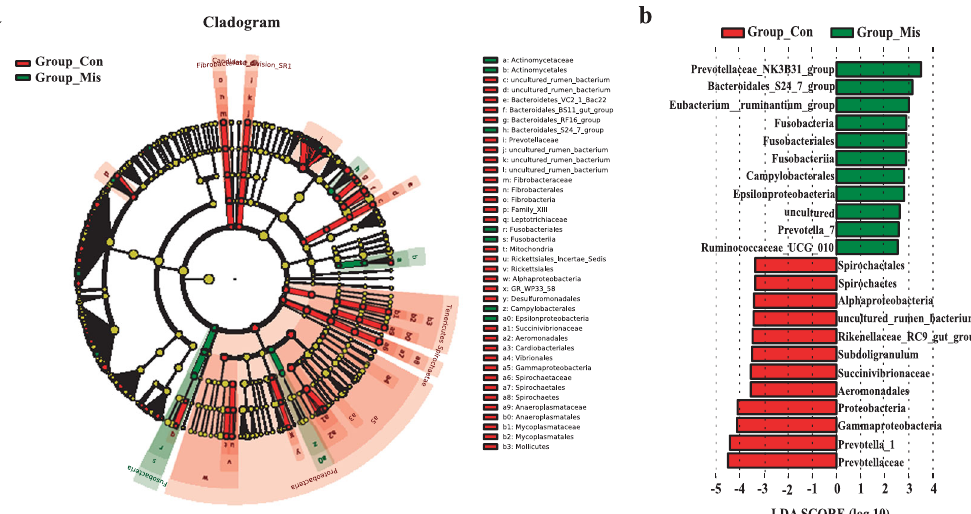
Fig. 3 Compositions of different species in the control and miscarriage groups by LEfSe analyses. a Taxonomic representation of statistically and biologically consistent differences between the control and miscarriage groups. Signi fi cant differences are represented with different colors (red and green represent core microbes in the control (Con) and miscarriage (Mis) groups, respectively; yellow represents microbes shared between the control and miscarriage groups). b Histogram of LDA scores for differentially abundant genera between the control and miscarriage